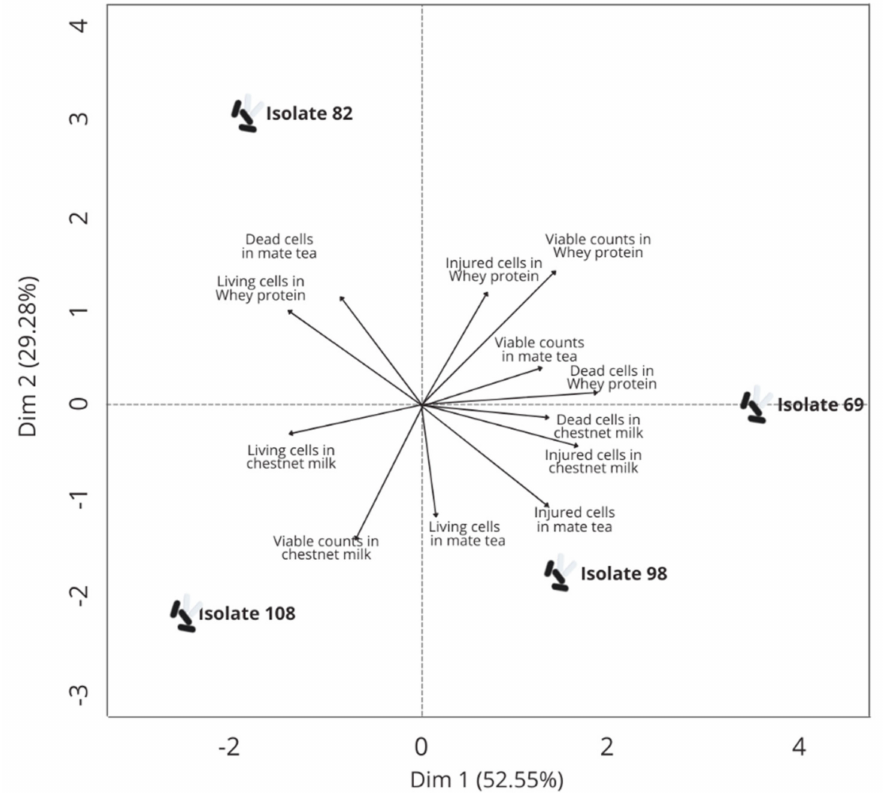
Figure 2. Principal component analysis (PCA) run of the variable projection to the survival of lactic acid bacteria isolates from xique-xique cladodes and fruit selected as having the most promising probiotic-related characteristics in different food matrices on day 21 of refrigeration